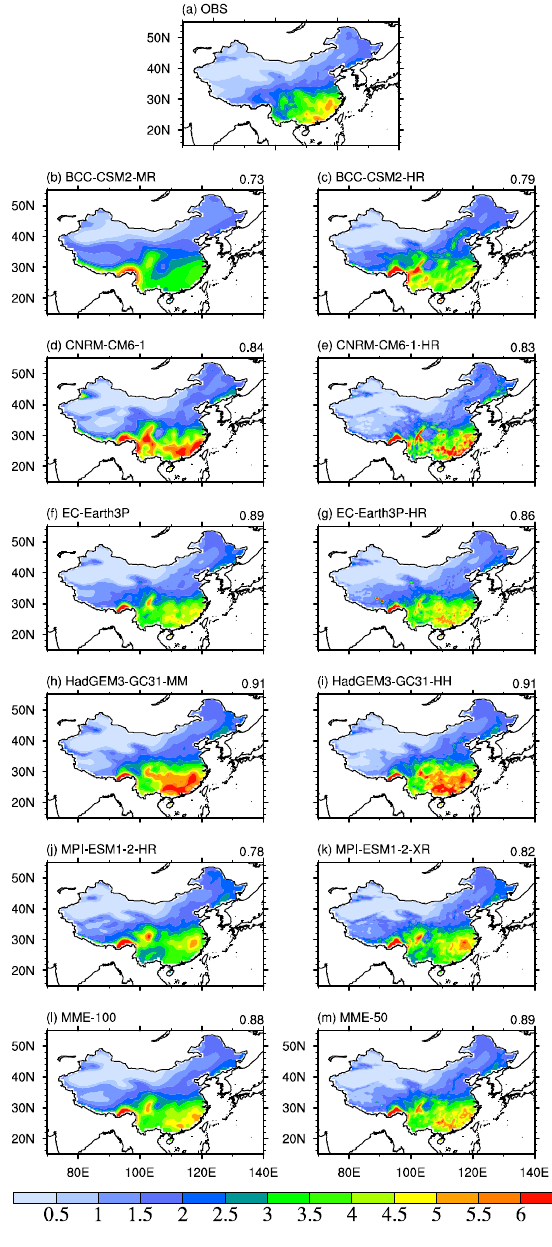
Figure 2. Distributions of climatological annual mean precipitation (mm/day) over China in the ( a ) observation, ( b – k ) models, ( l ) MME-100, and ( m ) MME-50. The number at the upper right of each figure is the spatial correlation coefficient between the model and the observation.